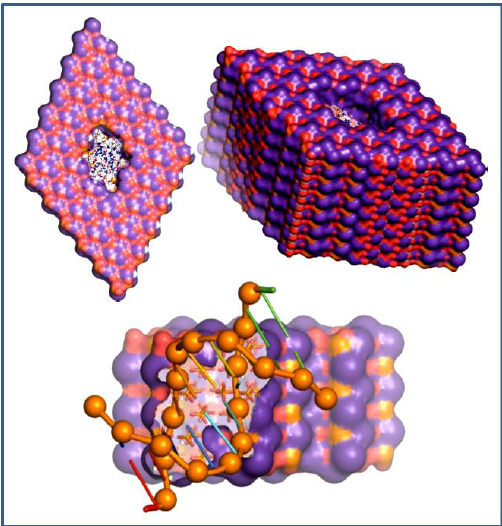
Figure 10. Simulated structure showing the double helix of B-DNA as a nucleating agent for